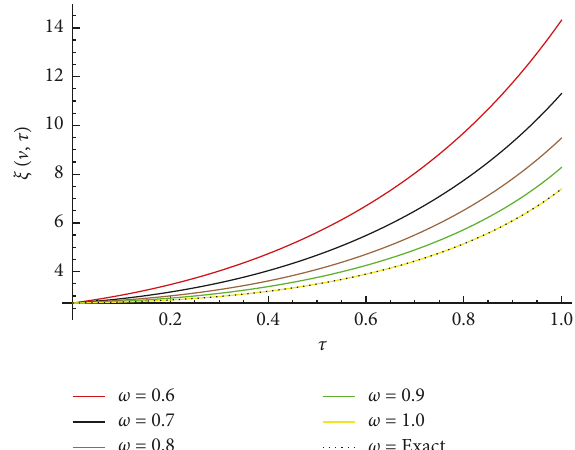
Figure 5: Approximate solutions for different values.